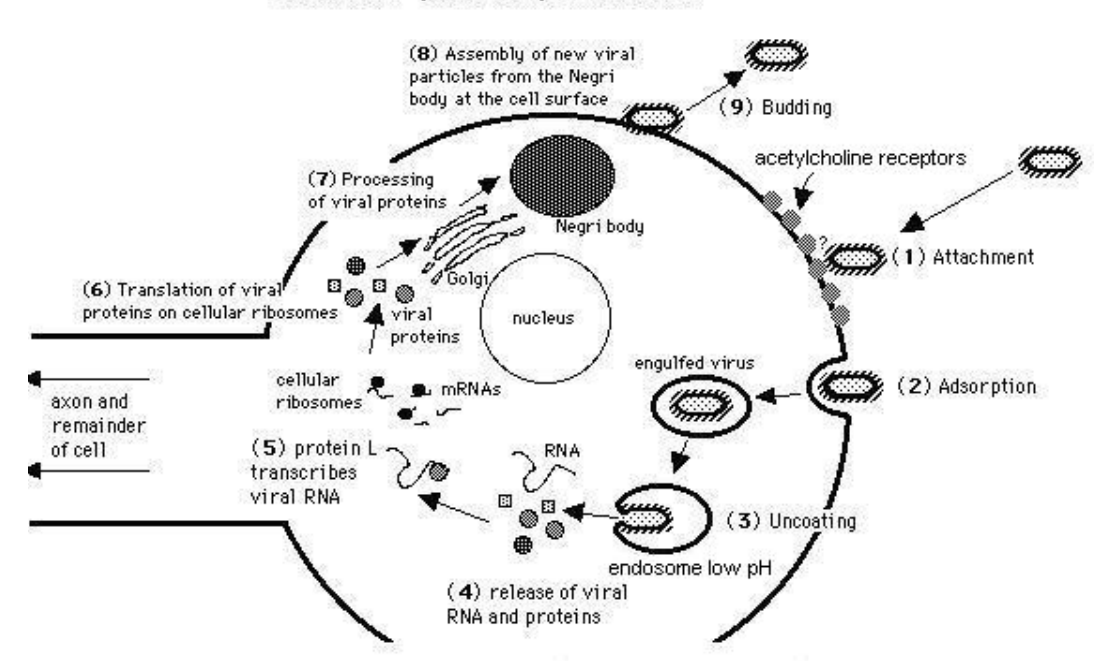
Figure 2: Cycle of viral infection and replication. Adapted from Mazarakis et al. (64). The incubation period or eclipse phase varies from 2 weeks to 6 years (average: 2 to 3 months) according to the amount of viral inoculum and the inoculation site. Bites on the head, face, neck and hands, particularly together with bleeding, offer the highest risk and are generally associated with a shorter incubation period. The RV can stay in the muscle tissue for long periods and in certain circumstances, its long persistence may provide an opportunity for host immune clearance and post- exposure treatment (45,